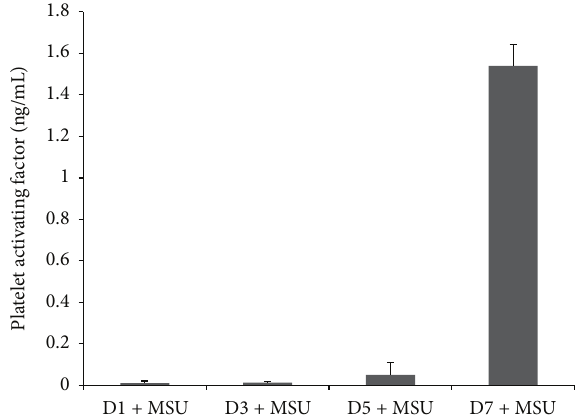
Figure 1: Monocyte differentiation and time course of platelet acti- vating factor (PAF) production after challenge with MSU crystals. Isolated monocytes were differentiated over 7 days in vitro and incubated with MSU crystals for 17 hours at day 1 (D1), day 3 (D3), day 5 (D5), and day 7 (D7) of culture. Collected supernatants were analysed for PAF secretion by ELISA. Results are mean and SEM of 4 experiments.